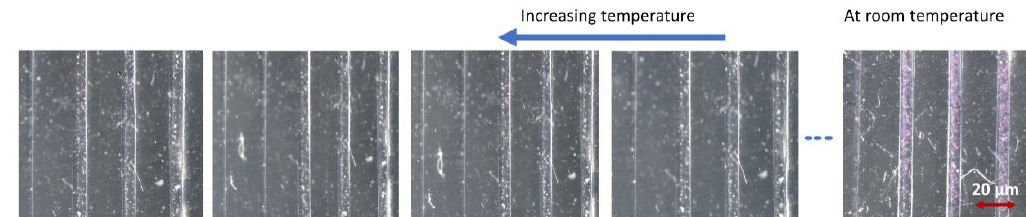
Figure 6. Image of the waveguide with amino-triazole complexes showing switching in color of the complex from pink-violet to white as the temperature increases from room temperature to approximately 35 °C.